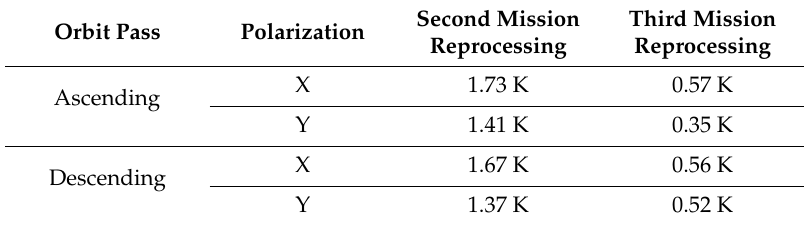
Table 2. Mean bias for the v620 data (second mission reprocessing) and the 724 data (third mission reprocessing), computed in the Pacific region between latitudes 45S and 10N. Orbit Pass Polarization